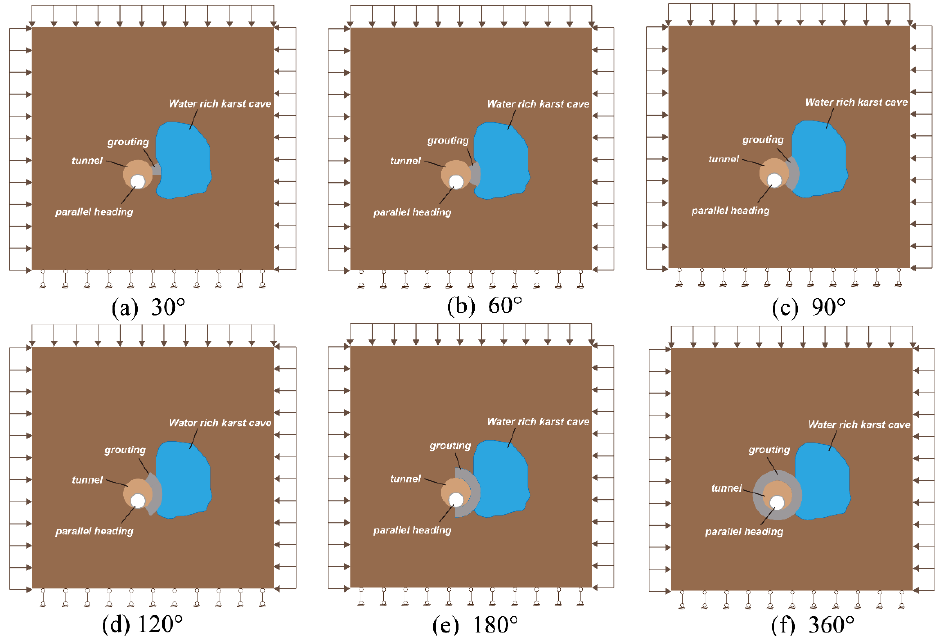
Figure 8. Schematic diagram of the numerical calculation model for different grouting ranges: ( a ) grouting range of 30 ◦ ; ( b ) grouting range of 60 ◦ ; ( c ) grouting range of 90 ◦ ; ( d ) grouting range of 120 ◦ ; ( e ) grouting range of 180 ◦ ; ( f ) grouting range of 360 ◦